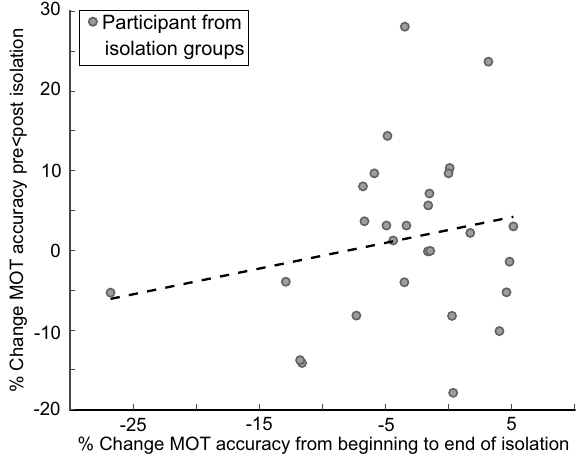
Figure 4. Percentage change in attended visual field from pre- to post-intervention correlated with percentage change in performance from first to last 10 min of